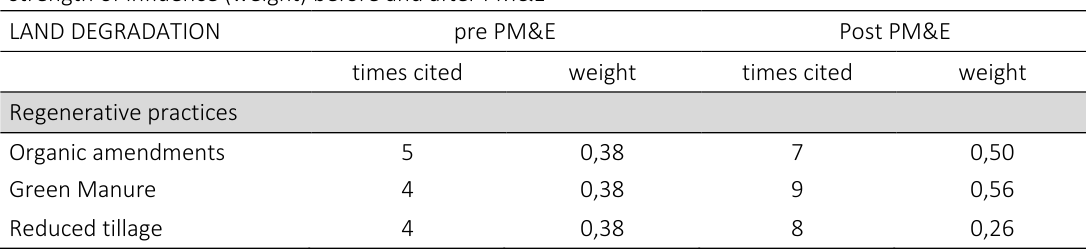
Table 1 Regenerative practices linked to Land degradation, times cited by participating farmers and strength of influence (weight) before and after PM&E LAND DEGRADATION